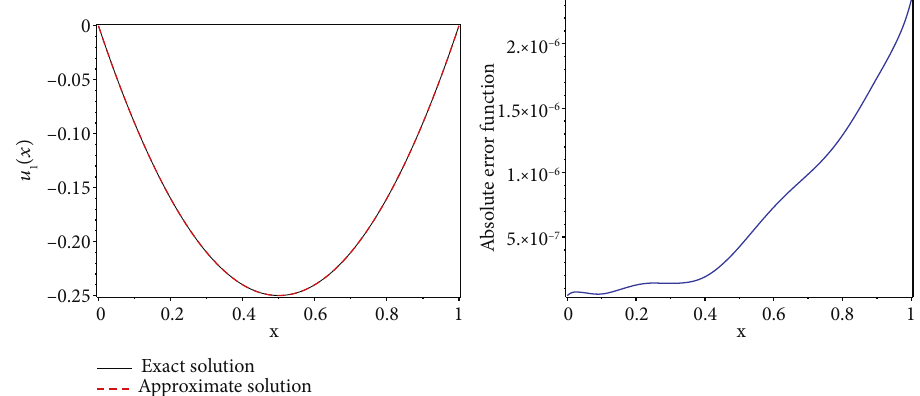
ð x Þ for N = 9 and ν 1